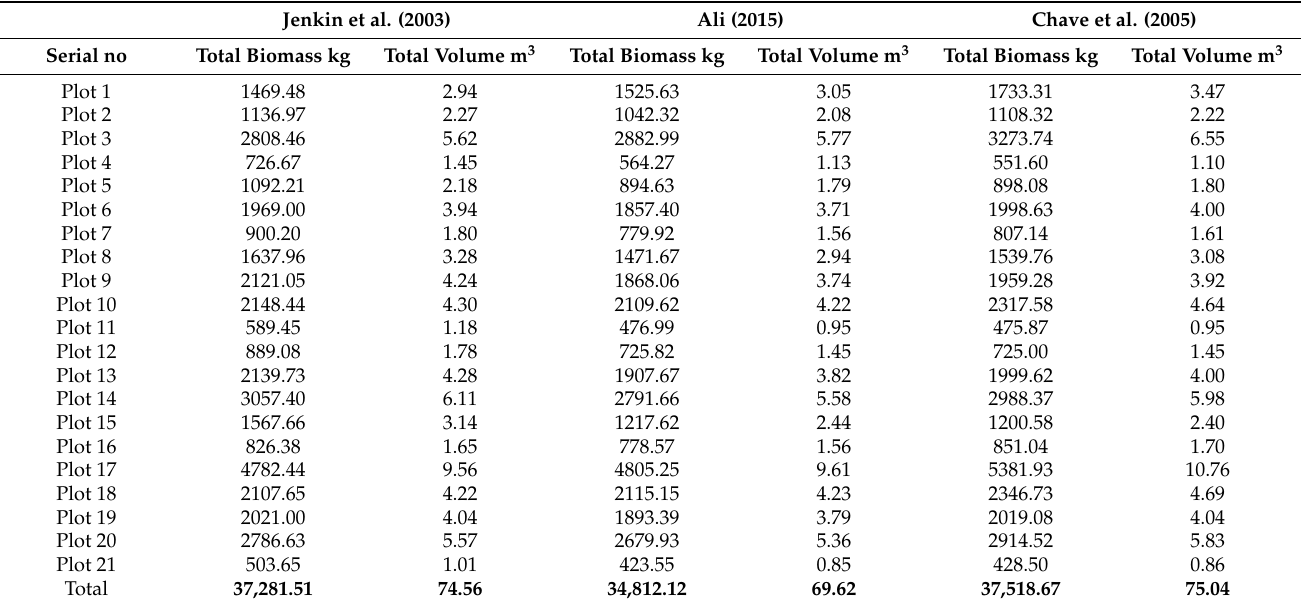
estimated using these equations were 74.56 m 3 , 69.62 m 3 and 75.04 m 3 . It can be noted that there was a small difference between the values of the equations of Jenkin et al. [15] and Chave et al. [33]. But there was a visible difference in the biomass and volume calculated using the equation of Ali [32]. Table 5. Comparison of total biomass and total volume of the three respective allometric equations.